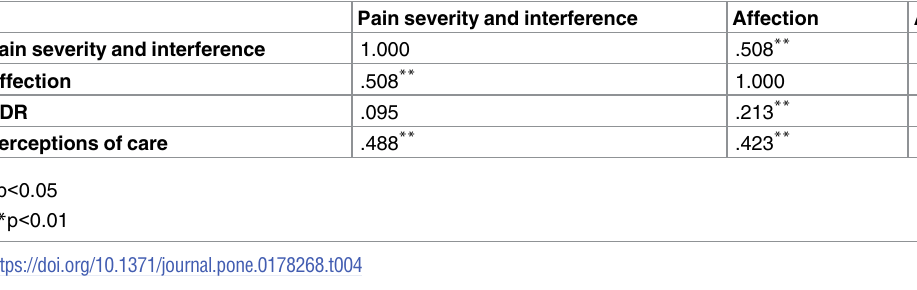
Table 4. Correlation matrix among